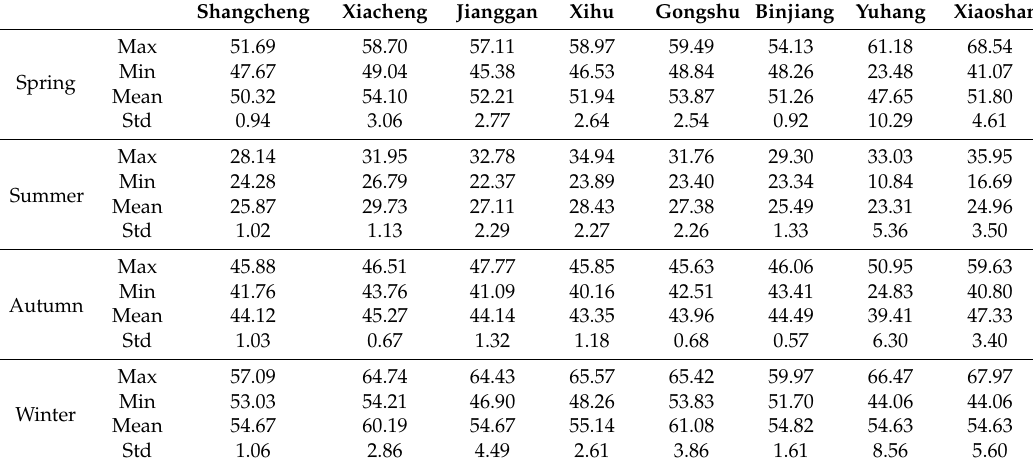
Table 2. PM 2.5 concentrations in the eight districts of Hangzhou by season in 2015, including maximum, minimum, mean and standard deviation values.